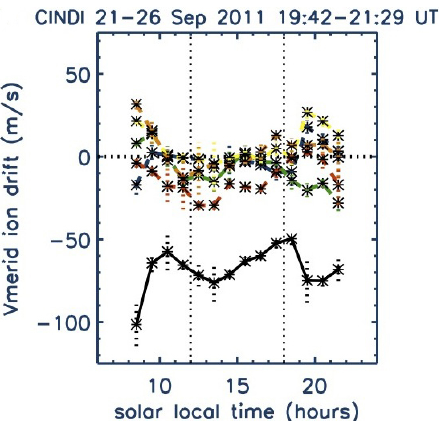
Figure 6. This plot shows the meridional flows observed during the fourth dayside pass of the satellite (20:36 to 21:29UT) after the storm’s onset (in black) compared to the baseline quiet day flows (in color). This pass demonstrates the largest excess downward flows observed during this storm event.